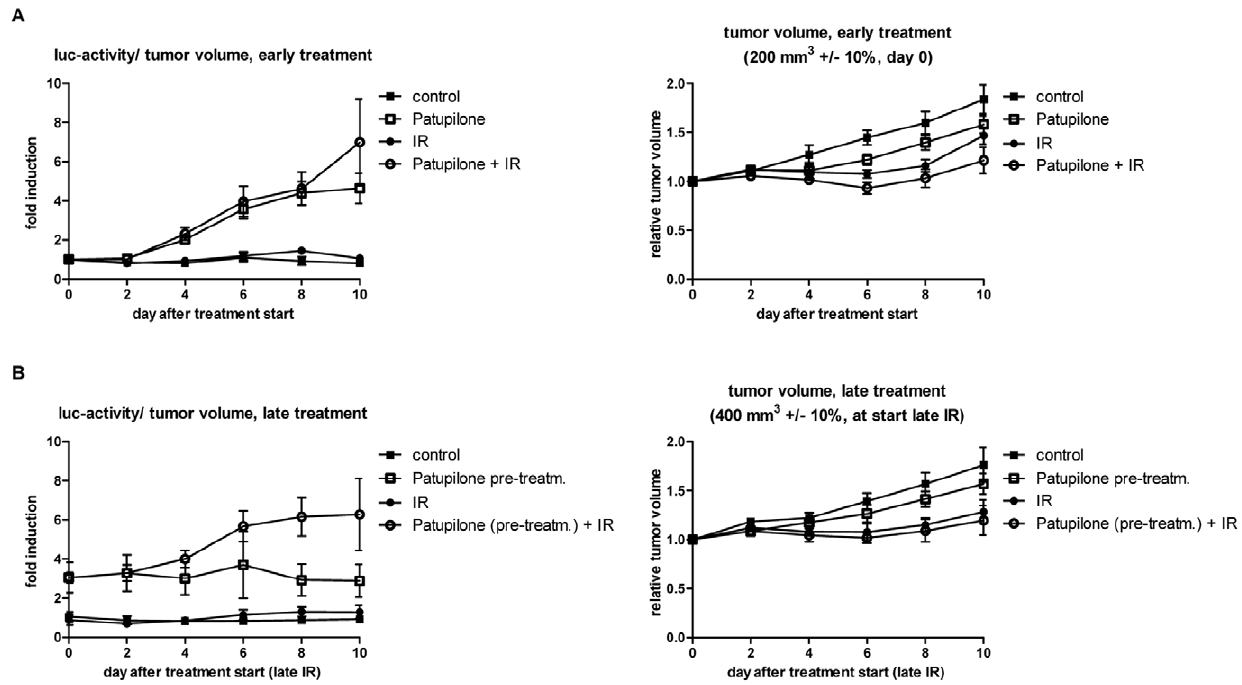
Figure 6. Tumor hypoxia in response to the combination of patupilone and ionizing radiation. (A) Luciferase activity and tumor growth of A549 ODD-Luc-derived xenografts in response to patupilone (2 mg/kg, day 0) and ionizing radiation (3 6 1 Gy, day 1–3) alone and in combination, treated at a tumor volume of 200 mm 3 6 10%. (n control =7; n IR =5; n patupilone =19; n combined =5) (B) Luciferase activity and tumor growth of A549 ODD- Luc-derived xenografts in control and patupilone-pretreated mice. Irradiation was performed at a tumor volume of 400 mm 3 6 10% (control) or 10 days after patupilone-pretreatment, (n control =7; n IR =5; n patupilone =6; n combined =5). Data used in Figure 4 and 5 are replotted into this figure for better comparison of the treatment groups. Error bars represent mean 6 SE of fold induction luciferase activity/tumor volume or relative tumor volume per group.